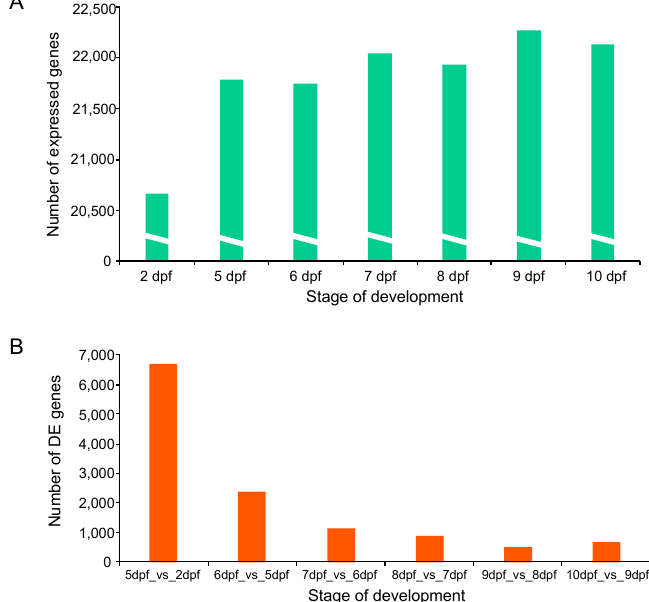
Figure 2. Gene expression during early development in channel catfish, Ictalurus punctatus . ( A ) Mean number of expressed genes of two replicates identified at each development stage. ( B ) The number of differentially expressed genes (DEGs) for comparison of each stage with the previous stage.